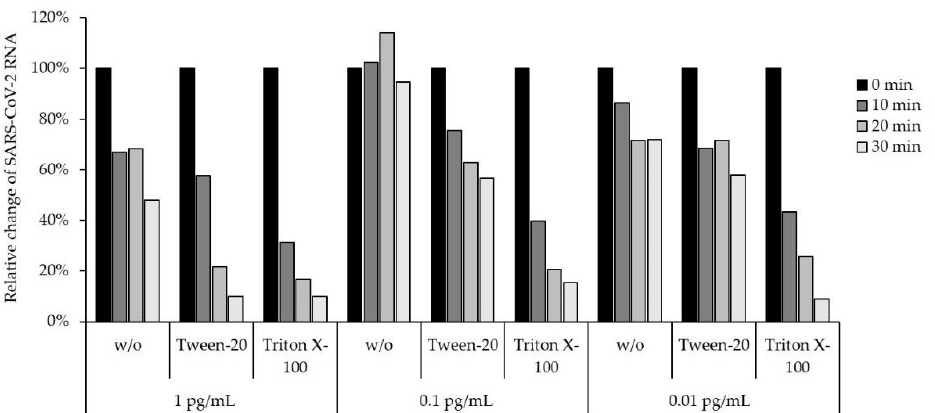
Figure 4. The use of Tween-20 or Triton X-100 detergents decreases the stability of SARS-CoV-2